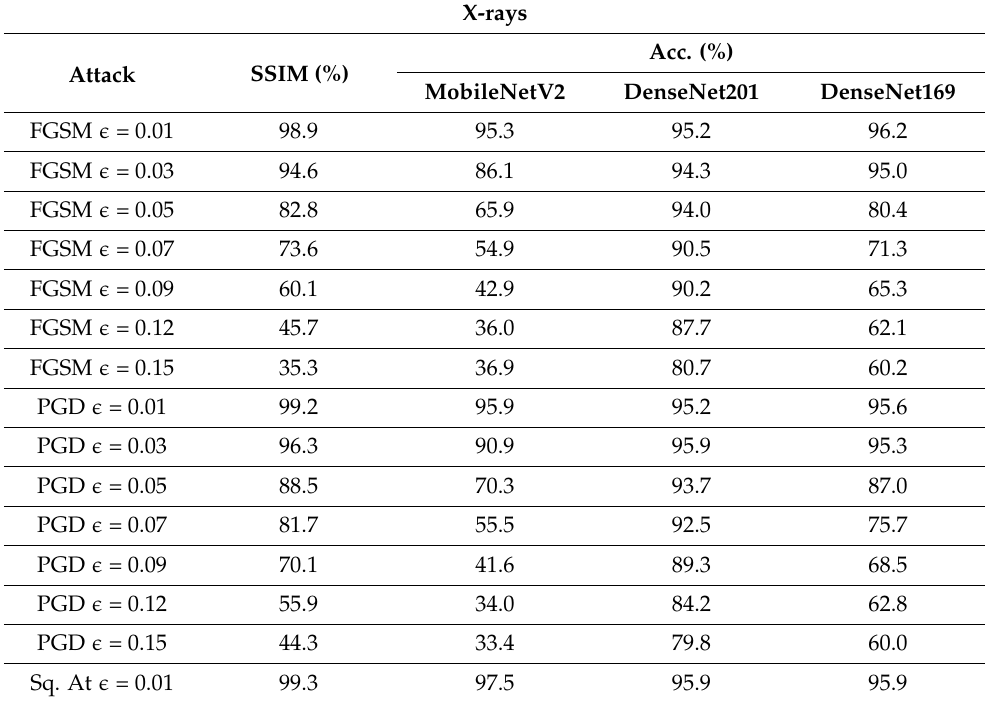
Table A7. SSIM index and performance for each attack in X-rays.